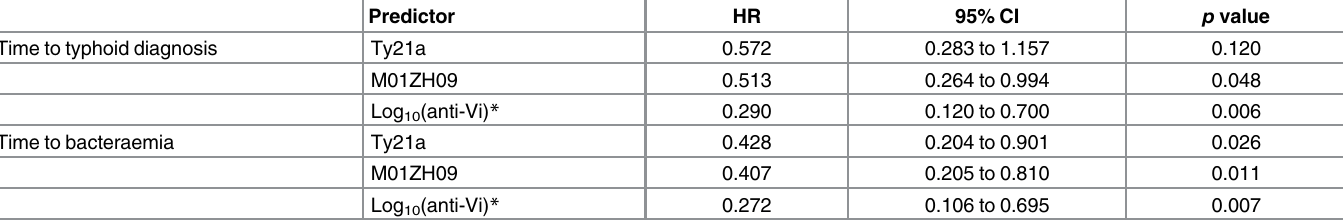
S1 Protocol. Understanding typhoid disease after vaccination: A single centre, randomised, double-blind, placebo-controlled study to evaluate M01ZH09 in a healthy adult challenge